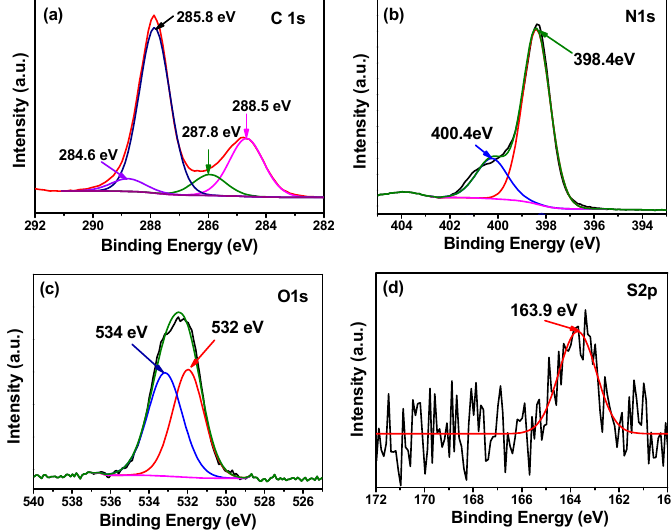
Figure 3. High resolution XPS core spectra of ( a ) C1s, ( b ) N1s, ( c ) O1s and ( d ) S2p of SCNPNS.